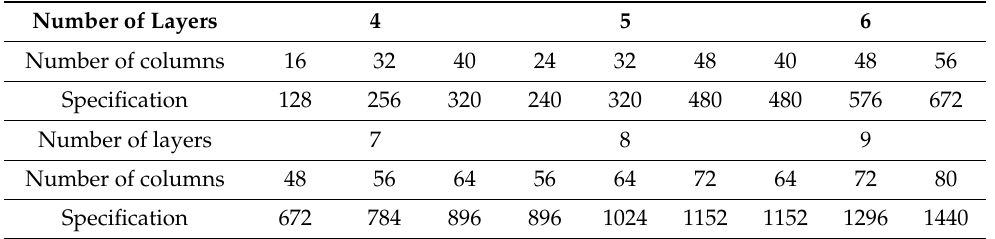
Table 9. System size parameters.